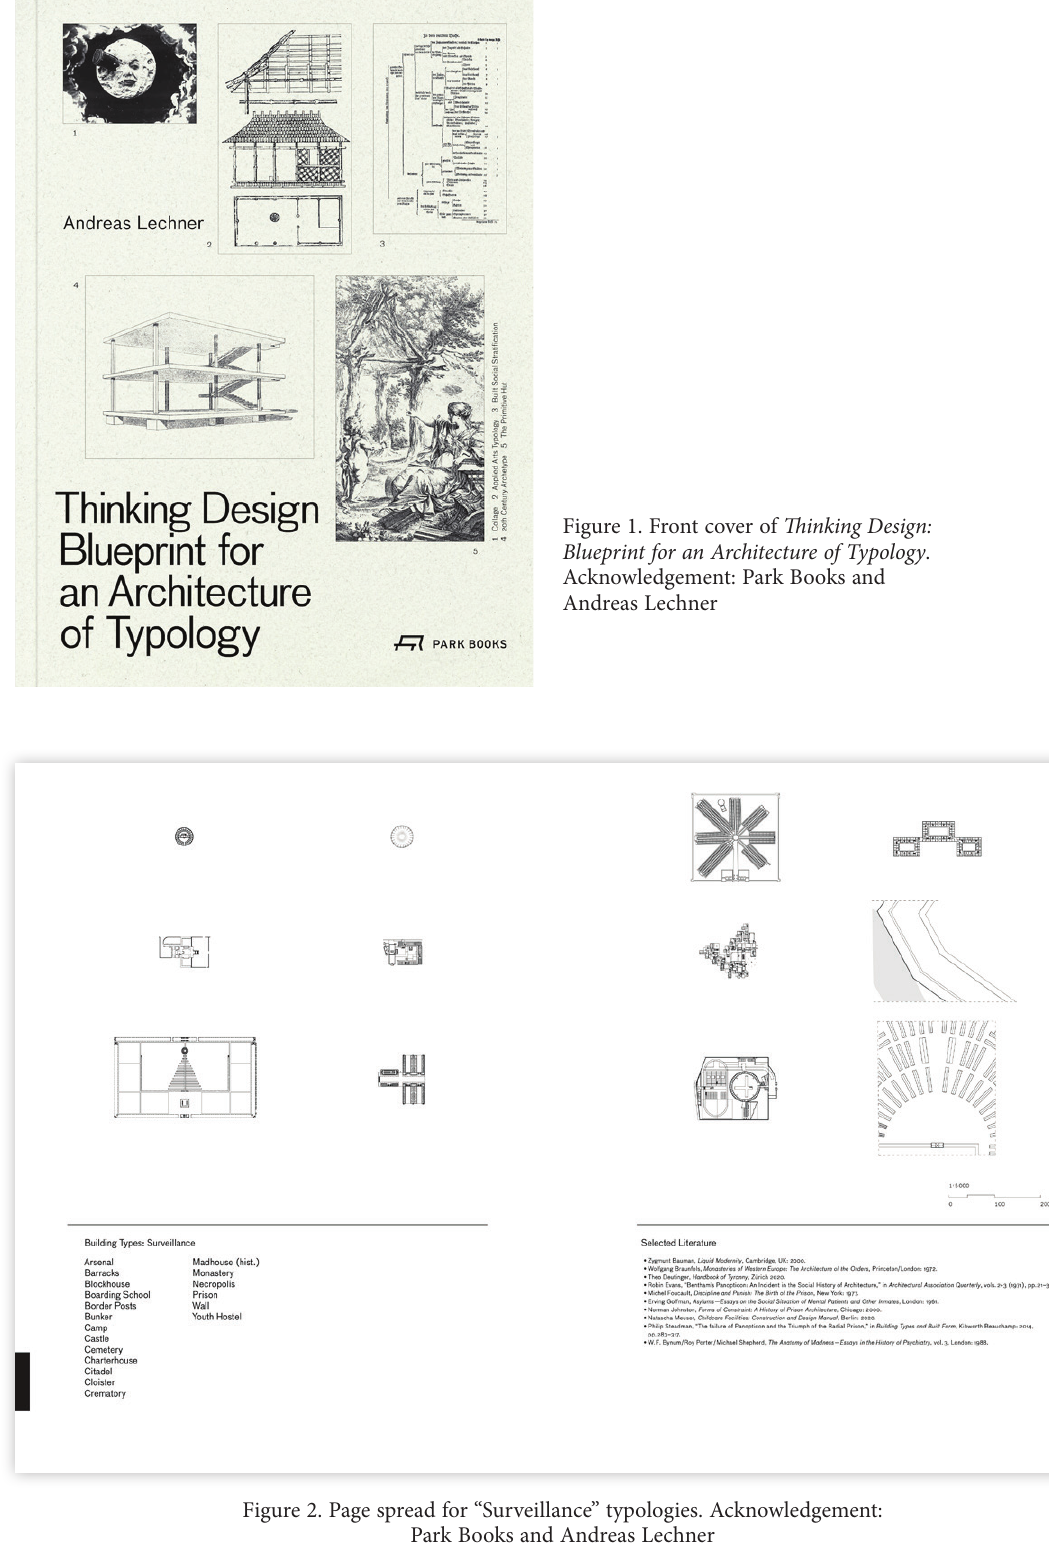
Figure 2. Page spread for “Surveillance” typologies.